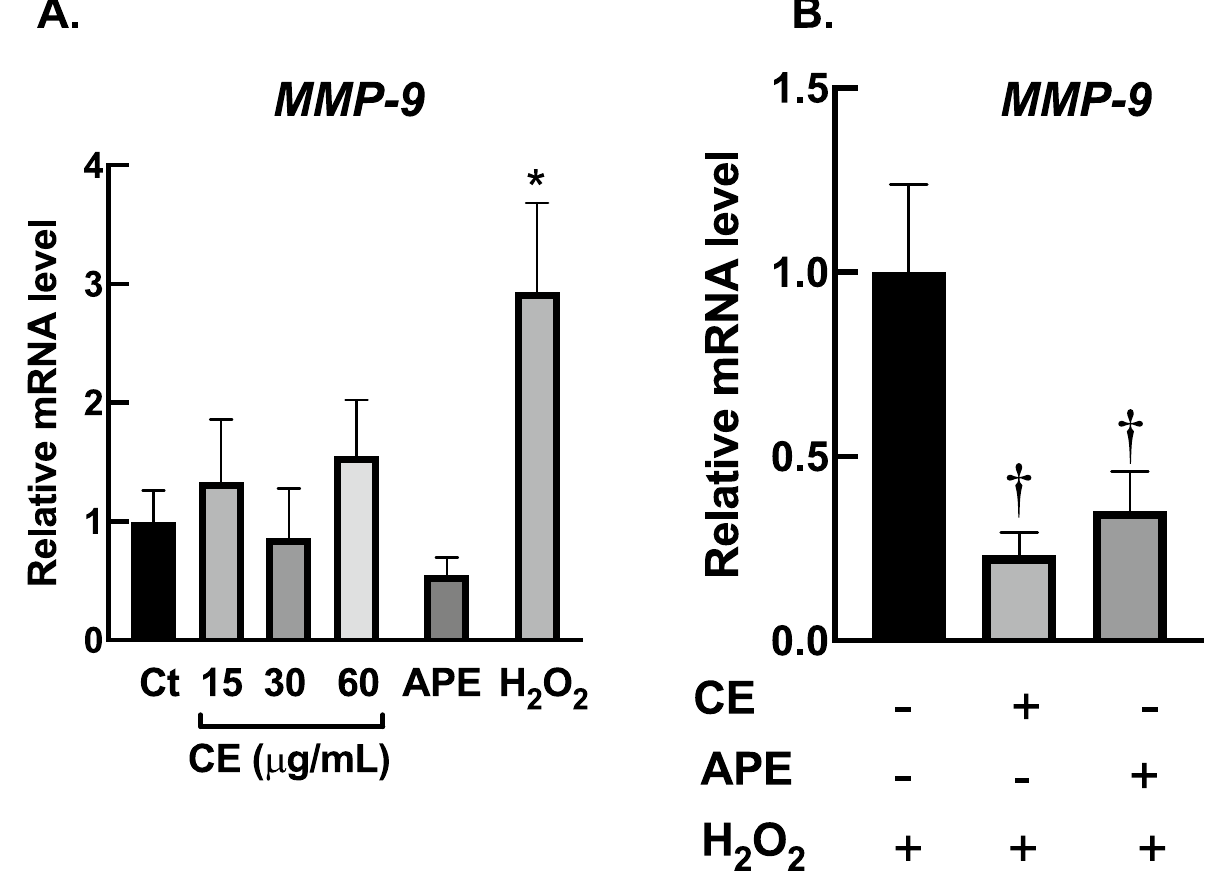
Figure 7. Centella extracts inhibit expression of MMP9 following H 2 O 2 treatment. ( A ) Exposure to H 2 O 2 resulted in elevation of MMP9 expression, while CE and APE did not affect the transcription of MMP9 . BJ cells were treated CE (15–60 µg/mL; 24 h) or APE (60 µg/mL; 24 h) or H 2 O 2 (200 µM; 1 h). ( B ) CE and APE suppressed H 2 O 2 -induced MMP9 expression. BJ cells were pre-incubated with CE or APE (60 µg/mL) for 24 h then exposed to H 2 O 2 (200 µM) for 1 h. The transcriptional levels of MMP9 were evaluated with RT-PCR following treatments ( n = 3; mean ± SEM; * P < 0.05 vs untreated control; † P < 0.05 vs H 2 O 2 -treated